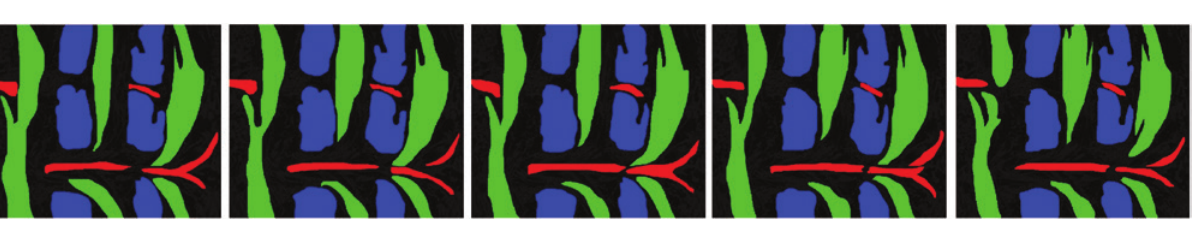
Figure 9: Slices with color marks.